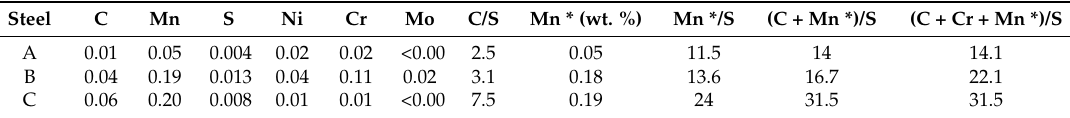
Table 1. Steels compositions (% by weight) and derived